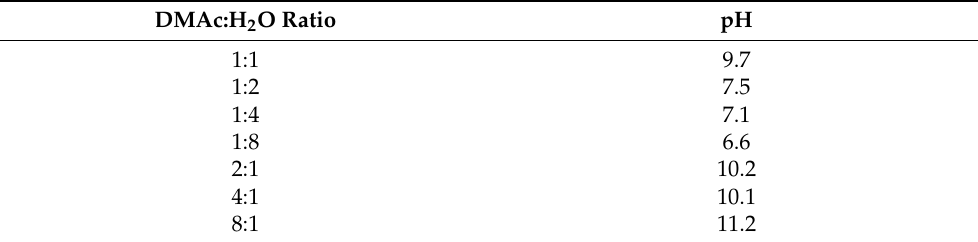
Figure 3. SEM images of ZIF-L after 8 h of exposure with ( a ) 1 M Zn 2+ , ( b ) 0.1 M 2mIm, ( c ) 0.01 M CTAB, and ( d ) 0.05 M CTAB containing DMAc/H 2 O solution at 333 K, ( e ) XRD pattern of crystals as illustrated in ( a – d ).